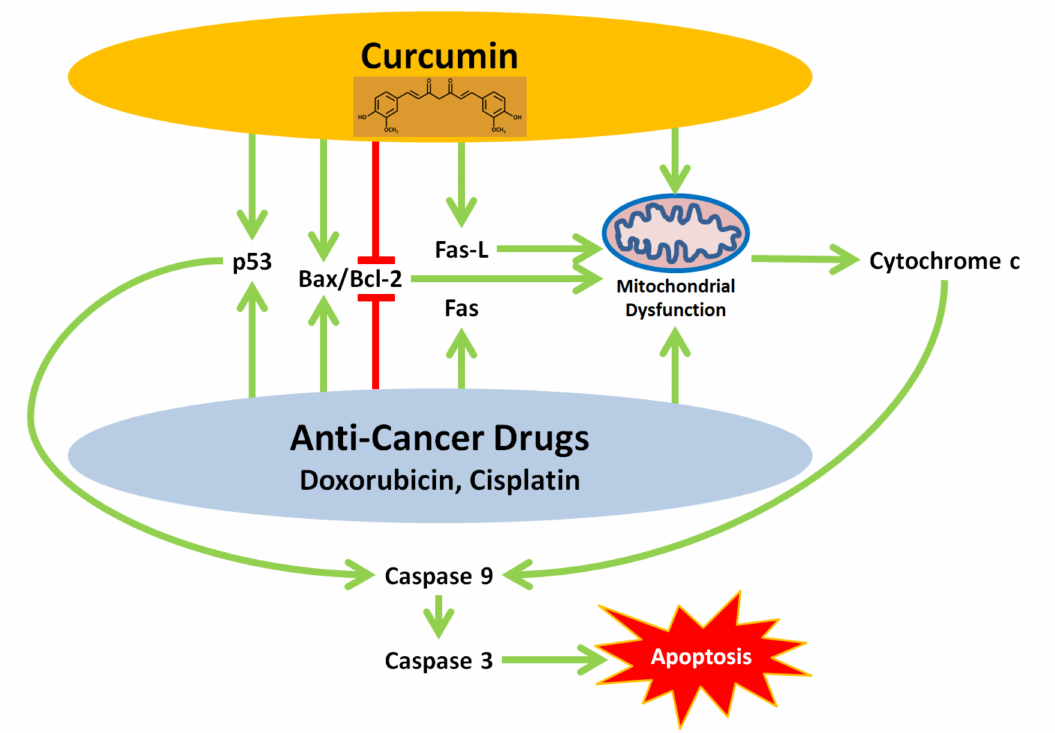
Figure 3. Oncologic signaling pathways are shared by curcumin and the anti-NB cancer drugs doxorubicin and cisplatin. Curcumin, doxorubicin, and cisplatin induce mitochondrial dysfunction through the upregulation of Bax and downregulation of Bcl-2. While curcumin also induces the Fas signaling pathway, doxorubicin does not, since it does not upregulate the ligand needed by the signaling pathway to proceed (Fas-L). Ultimately, the pathways lead to the activation of caspases and apoptosis. Synergistically, curcumin potentiates the cytotoxic and pro-apoptotic e ff ects of doxorubicin in SH-SY5Y and SK-N-AS cells [69,80]. This e ff ect may be of clinical relevance, since it occurred at relatively low doses (0.05 µ g / mL; 0.5–1.5 µ M) of doxorubicin, which may feasibly be obtained in